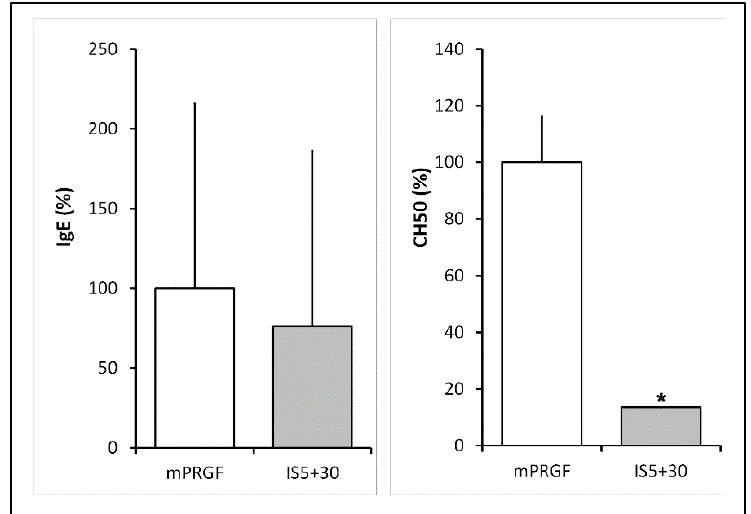
Figure 1. IgE and complement activity levels in non-heat treated (mPRGF) and heat-treated (IS5+30) membranes. IgE levels were reduced by 20% in the heat-treated membrane (IS5+30) regarding mPRGF. No significant differences were observed in the IgE levels between the mPRGF and IS5+30. Heat treatment completely reduces complement activity in the mPRGF incubated at 37 °C for 5 min and at 56 °C for 30 min (IS5+30) compared to the mPRGF. * p < 0.05.